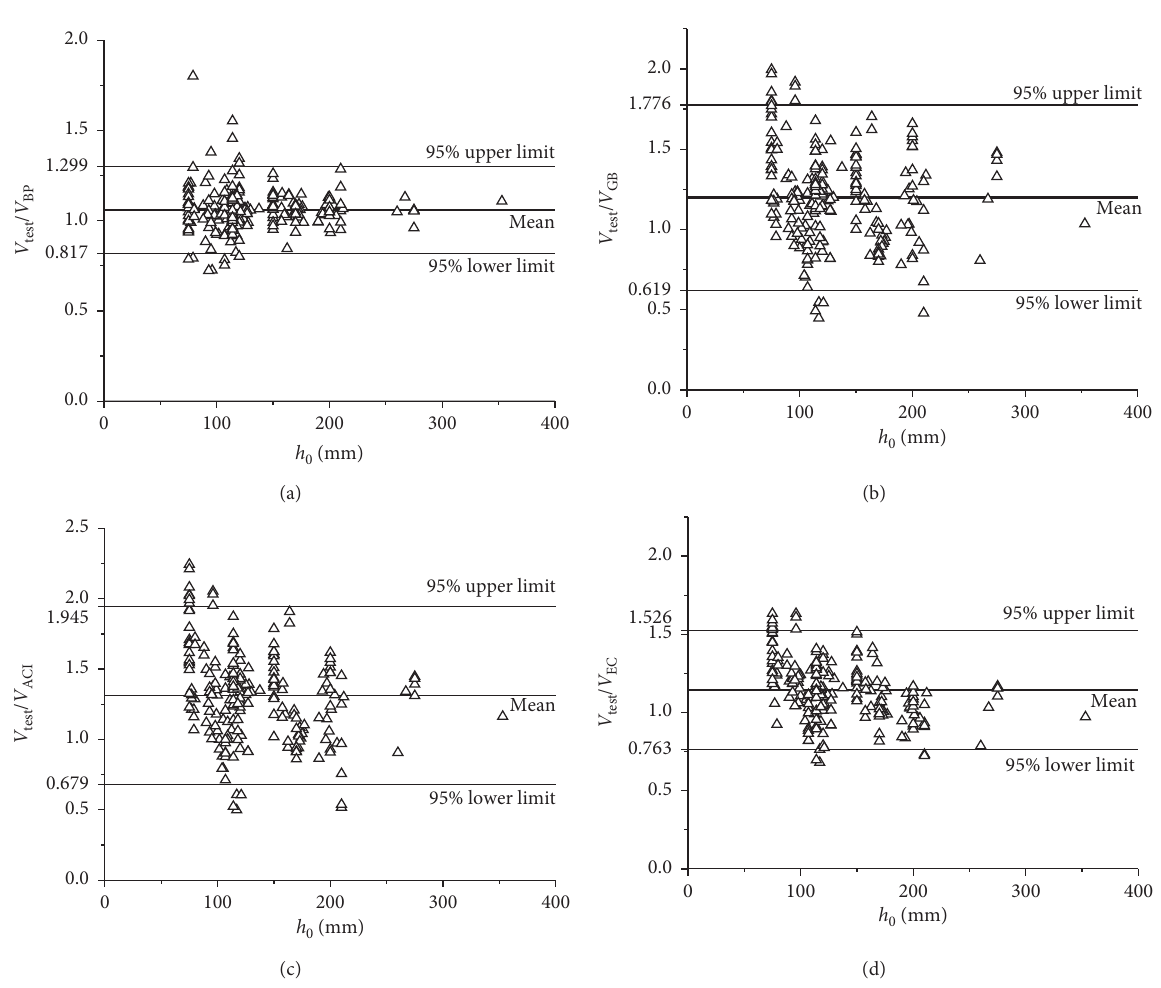
Figure 6: Influence of h on the ratio of the test value to the predicted value. (a) BPNN model. (b) GB 50010-2010. (c) ACI 318-14. (d) EC 0